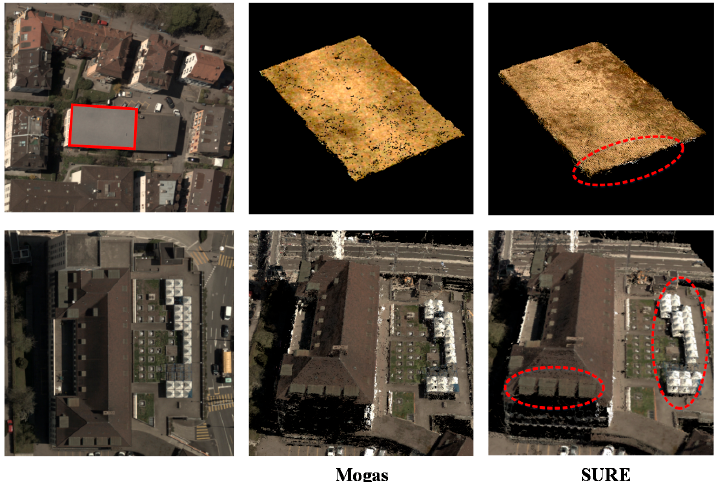
Figure 12. Multi-view dense matching results from the proposed method and SURE (From left to right: Origin images, matching results from the proposed method, and matching results from SURE).